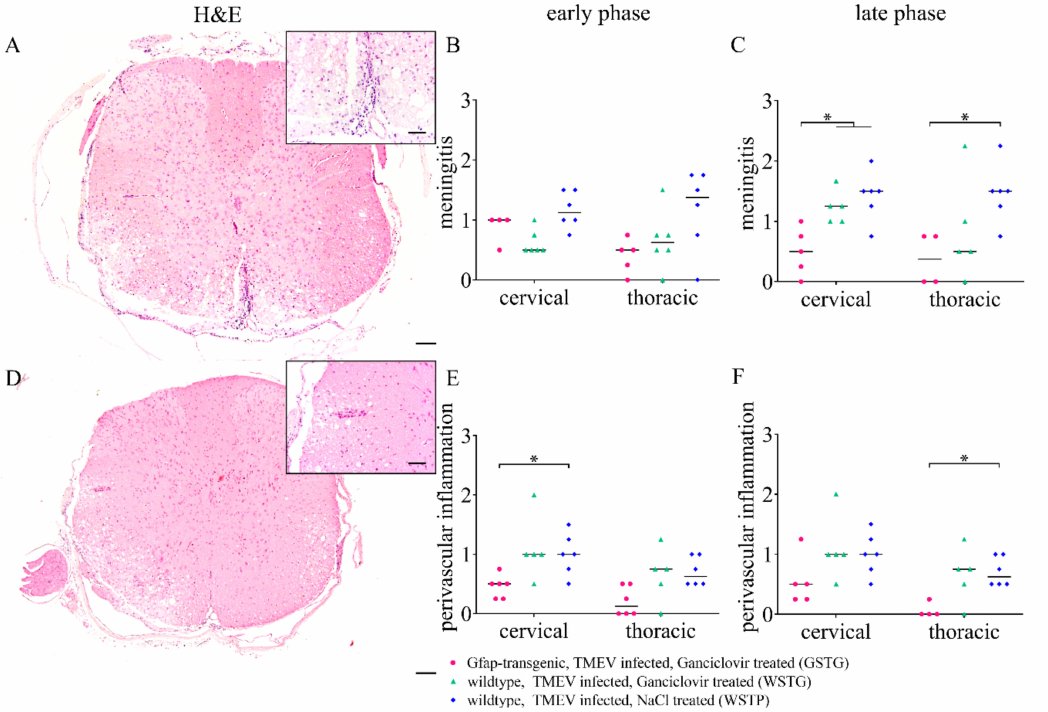
Figure 7. Quantification of meningeal and perivascular inflammation. Meningitis and perivascular inflammation in the cervical and thoracic spinal cord white matter were quantified using hematoxylin and eosin (H&E) staining. Statistical analysis revealed a significant reduction of meningitis in TMEV infected, ganciclovir treated, Gfap -transgenic (GSTG) mice at 77 days post infection (dpi; late phase; A – C ). Perivascular inflammation in the white matter of the cervical spinal cord at 46 dpi (early phase; E ) and of the thoracic spinal cord at 77 dpi (late phase; F ) was significantly reduced in GSTG animals. The inserts in A and D show higher magnifications. Data are shown as scatter dot plots. Significant di ff erences between the groups obtained by Kruskal–Wallis test followed by Mann–Whitney U post hoc tests were indicated by *, p < 0.05. Bars represent 100 µ m in the overviews and 50 µ m in the